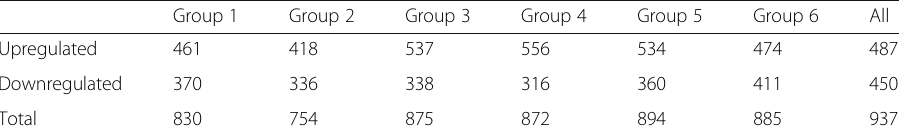
Table 3 The differentially expressed genes in all transcriptome groups Group 1 Group 2 Group 3 Group 4 Group 5 Group 6 All Upregulated 461 418 537 556 534 474 487 Downregulated 370 336 338 316 360 450 Total